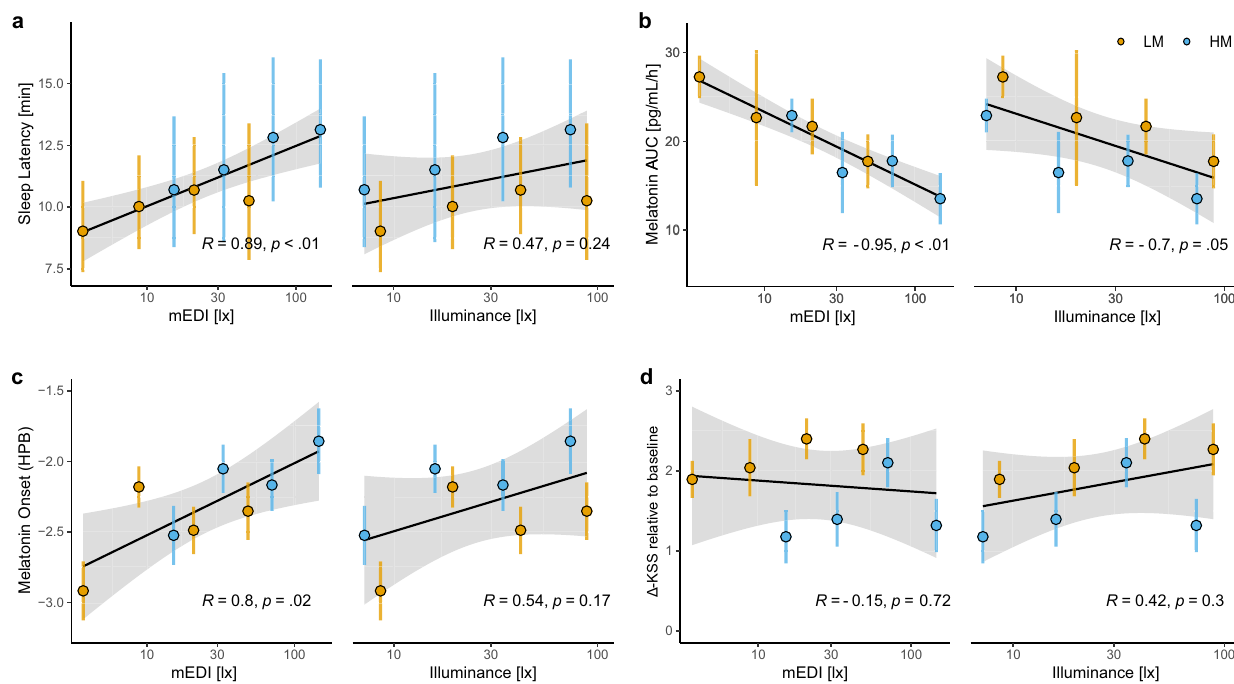
Fig. 5 Dose-response relationships with log10-transformed mEDI [lx] and photopic illuminance [lx]. Averages per light condition over all light intensity groups entered the calculation of the regression models. Dose dependencies were calculated for a Sleep latency [min], depicted are back-transformed means and 95% CIs ( n = 18 per group, except LM intensity 1 n = 17) and the regression line (Mean values of all light conditions, n = 8), b Melatonin area under the curve (AUC) [pg/mL/h], depicted are means ± 1SEM groups (Intensity 1: n = 15, intensity 2: n = 14, intensity 3: n = 18, intensity 4: n = 18) and the regression line (Mean values of all light conditions, n = 8), c Melatonin onset in hours prior individual bedtime (HPB), depicted are means ± 1SEM (Intensity 1: LM n = 15, HM n = 17; intensity 2: LM n = 15, HM n = 15; intensity 3: LM n = 16, HM n = 16; intensity 4: LM n = 16, HM n = 15) and the regression line (Mean values of all light conditions, n = 8), d Baseline-corrected subjective sleepiness (KSS), depicted are means ± 1SEM ( n = 18 per intensity group) and the regression line (Mean values of all light conditions, n = 8). Orange points show means of the low melanopic and orange lines 95% CIs or SEM. Blue points depict means of the high melanopic and blue lines 95% CIs or SEM. The grey bands represent the 95% con fi dence interval